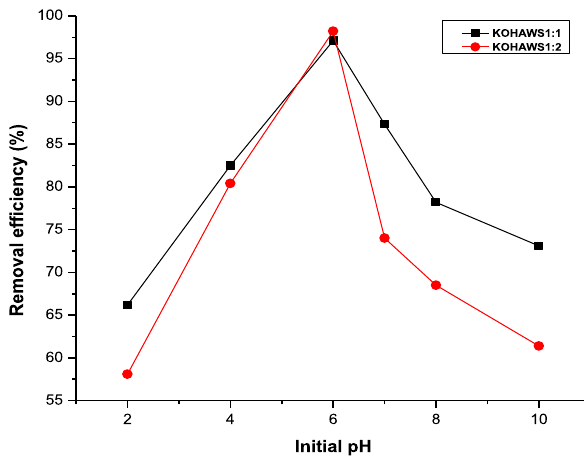
Fig. 6 Effect of solution pH on deltamethrin removal efficiency of KOHAWS1 and KOHAWS2